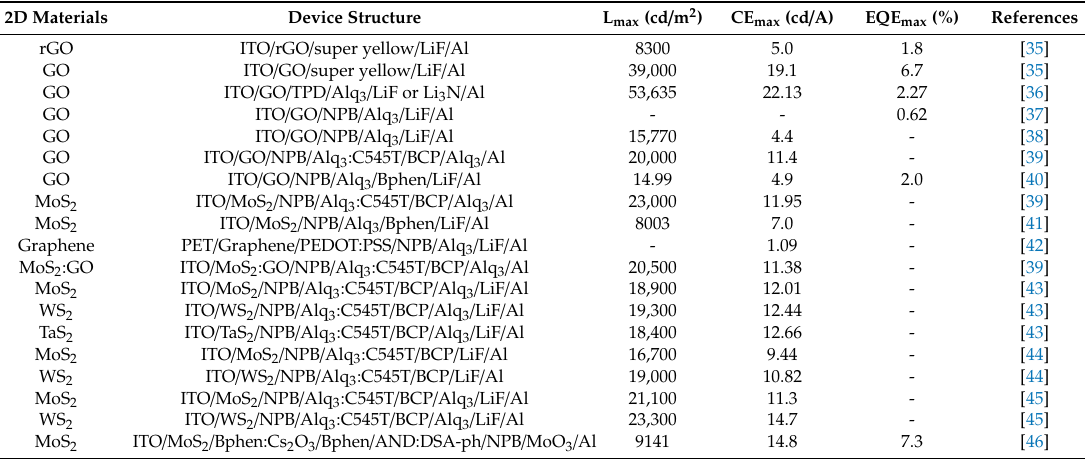
Figure 2. Schematic structures of organic light emitting diodes (OLEDs), in which organic materials such as emission layers (EML) and 2D materials such as ( a ) hole transport layer (HTL), ( b ) hole injection layer (HIL), ( c ) dopant in HTL. Table 1. Summary of the device parameters of OLEDs with 2D materials interlayers.